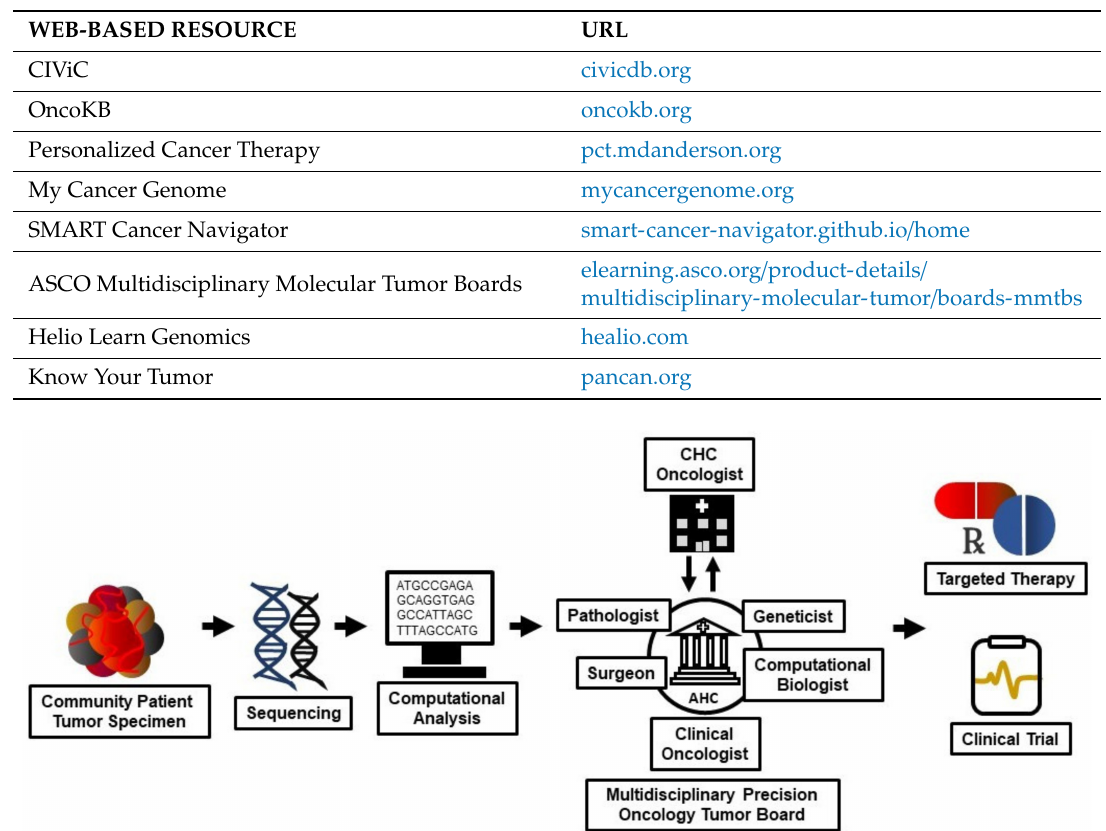
Table 1. Web-based genomics resources available to community oncologists.